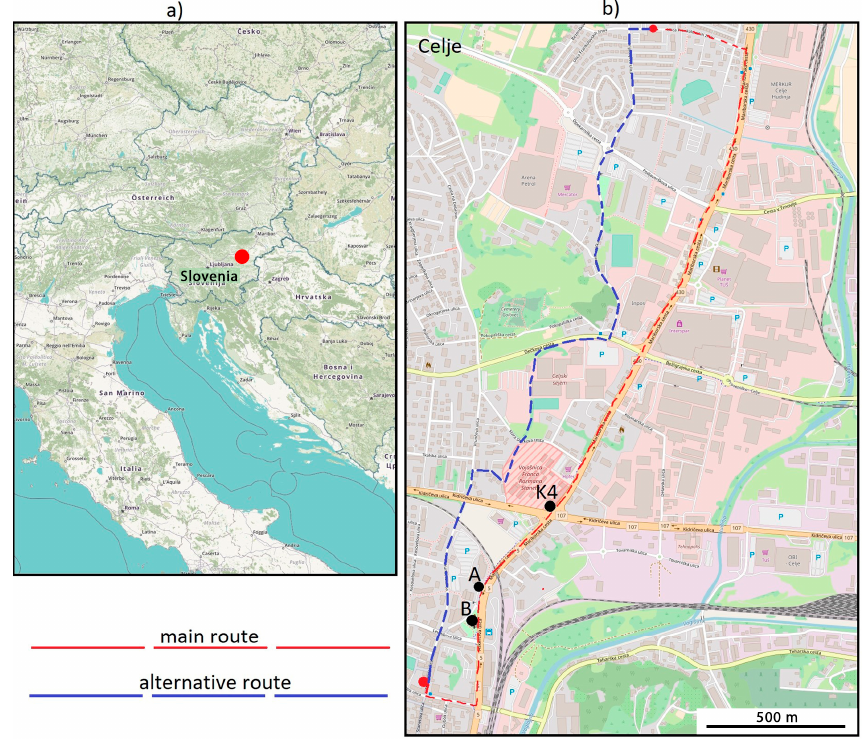
Figure 1. ( a ) Location of Slovenia and Celje (marked with red dot). ( b ) Map of Celje with the highway and main roads (basemap source: © OpenStreetMap). Measurement sites: A—urban background and traffic sites: intersection K4 and site B. Dashed lines represent the existing main (red) and alternative (blue) cycling routes.